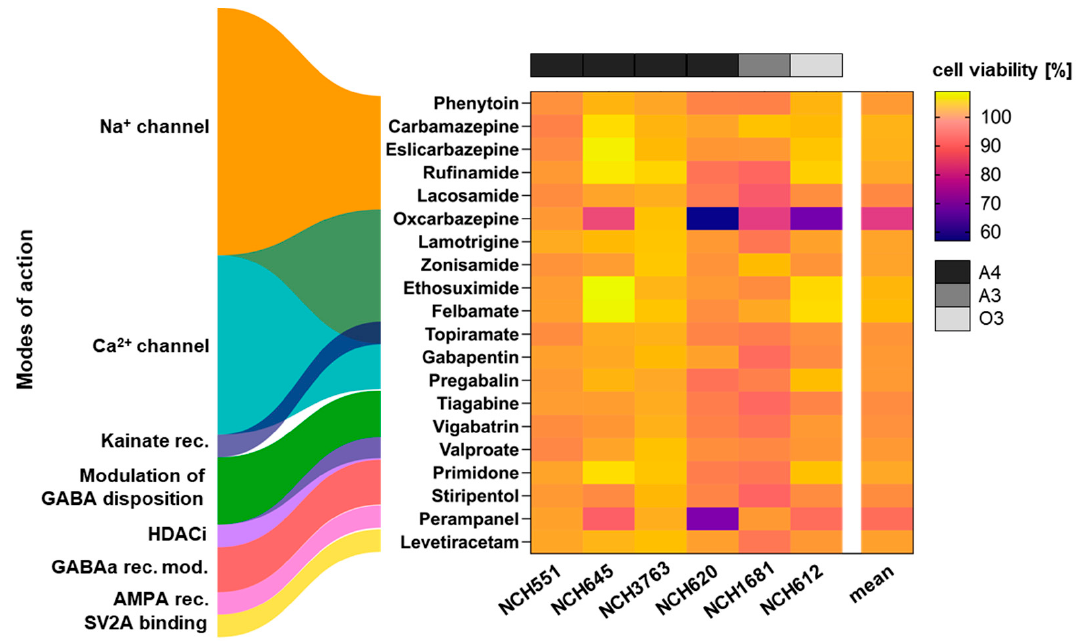
Figure 1. Drug screen for antineoplastic drug activity in IDH mut GSCs representing aggressive IDH mut gliomas. A total of 20 antiepileptic drugs (AEDs) were tested for antiproliferative properties at a concentration of 10 µ M. Most AEDs are thought to exert their antiepileptic effect by modifying the electrolyte flux through the neuronal cell membrane, although overlapping modes of action exist, as depicted by the overlapping colors. Oxcarbazepine and perampanel show an antiproliferative effect in several GSCs, as depicted by the violet coloring in the heatmap. The experiments were performed in biological and technical triplicates. Rec. = receptor; mod. = modifier; GABA = gamma- aminobutyric acid; HDACi = histone deacetylase inhibitor; AMPA = α -amino-3-hydroxy-5-methyl-4- isoxazolpropionic acid; SV2A = synaptic vesicle glycoprotein 2A; A4 = astrocytoma WHO grade 4; A3 = astrocytoma WHO grade 3; O3 = oligodendroglioma WHO grade 3.